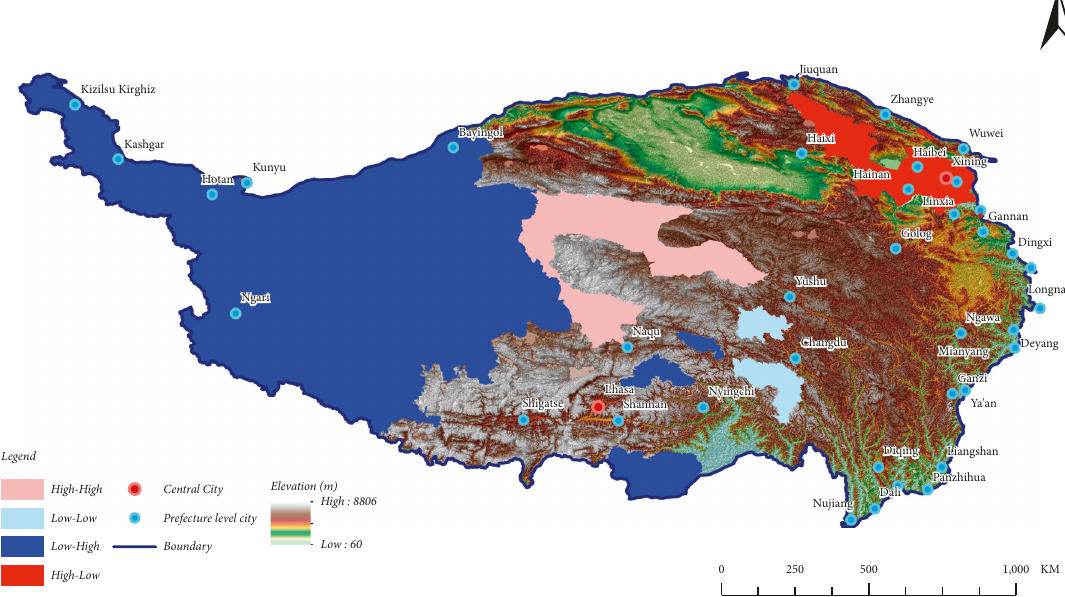
Figure 15: Distribution of spatial agglomeration relationships between the TIID and NLDI .